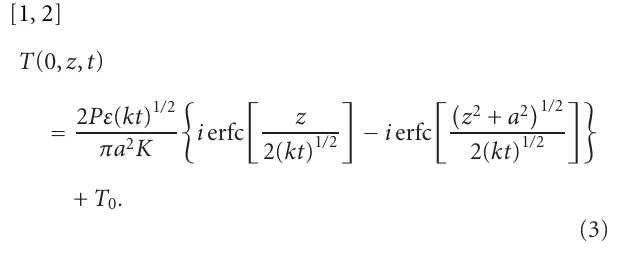
Figure 2: Dimensionless temperature θ versus dimensionless time for various depths when heating with continuous disk (—) and Gaussian (--) sources [1].